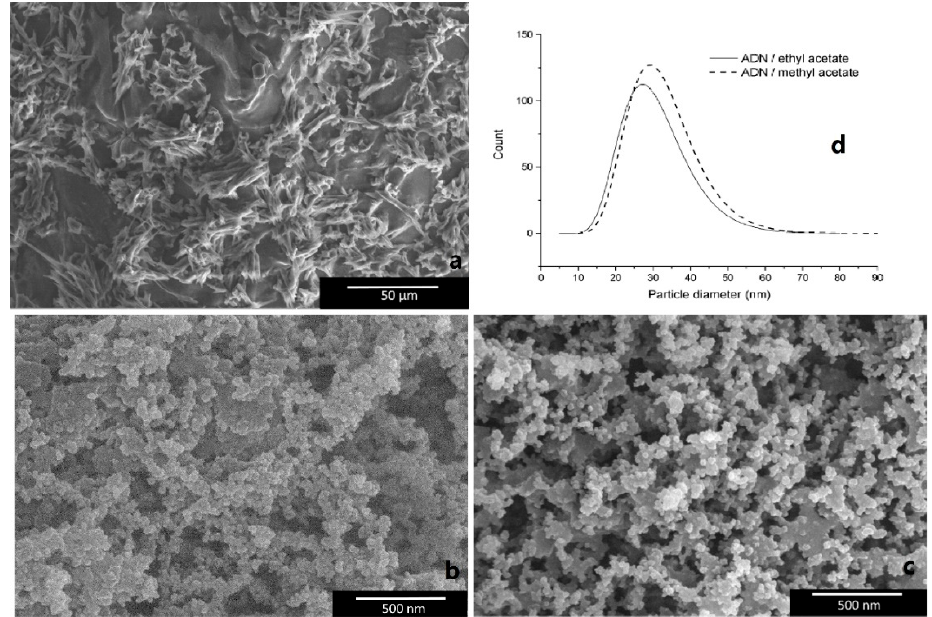
Figure 8. SEM images of raw ADN and nADN. ( a ) Raw ADN; ( b ) ADN crystallized in ethyl acetate; ( c ) ADN crystallized in methyl acetate; ( d ) log-normal size distribution of ADN crystallized in methyl acetate and ethyl acetate. Reproduced from [67], with permission from Propellants, Explosives, Pyrotechnics, 2012.